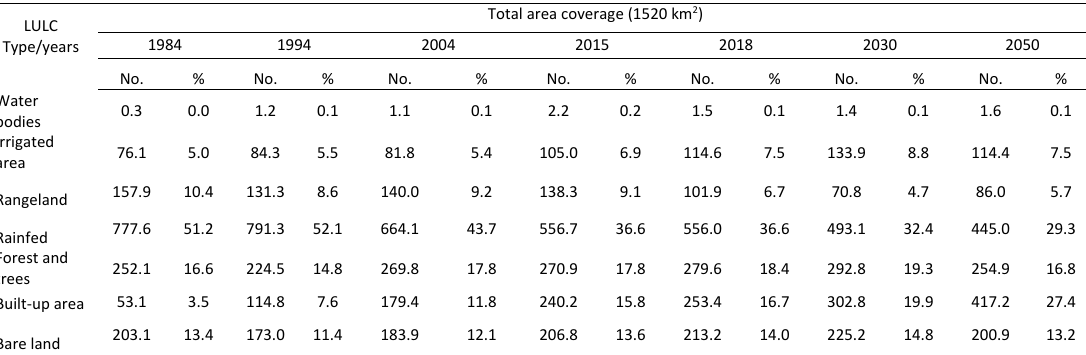
Table 7: Summary of LULC changes during the period 1984 to 2018 in Irbid governorate.